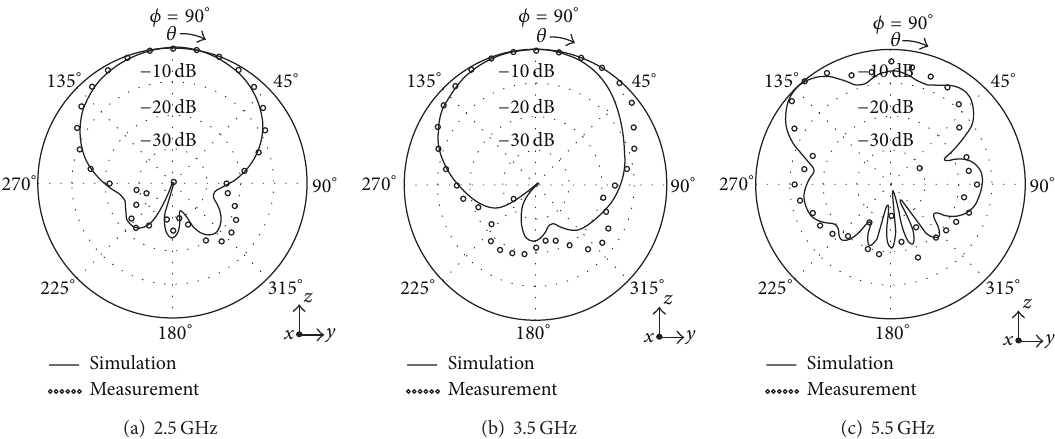
Figure 11: The comparison between the simulated and measured radiation patterns in the 𝑦𝑧 -plane.